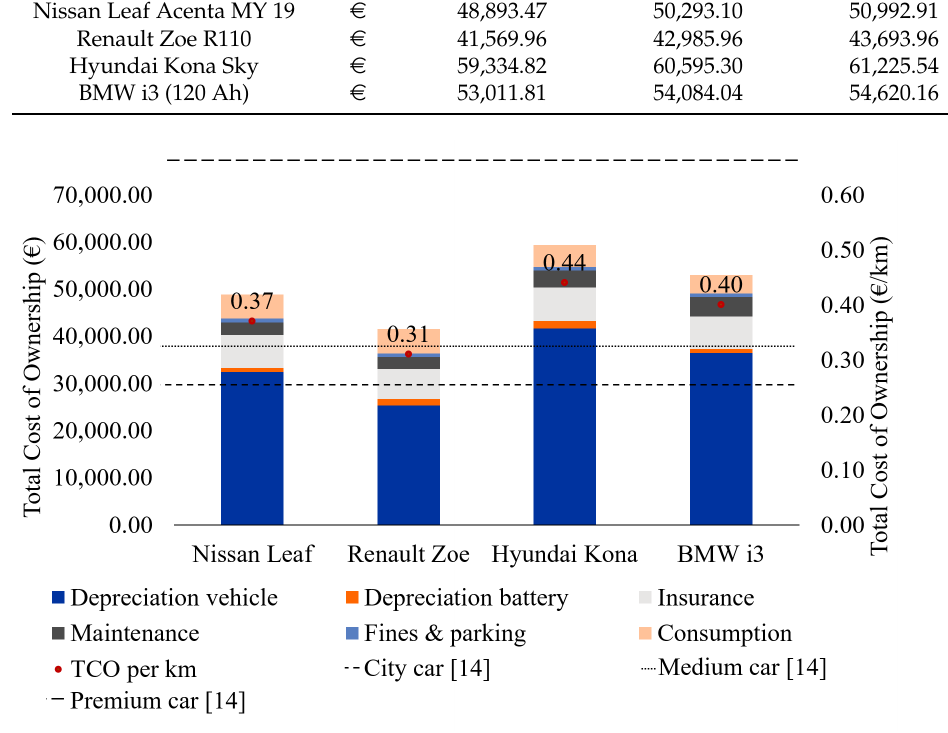
Figure 4. Standard TCO in a private charging case (source: own